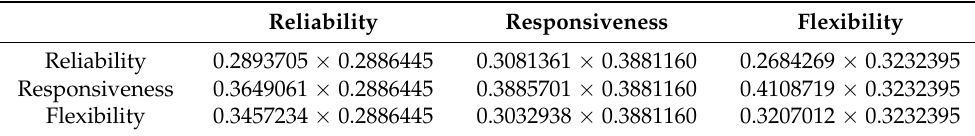
Table A4. Calculation of the consistency ratio